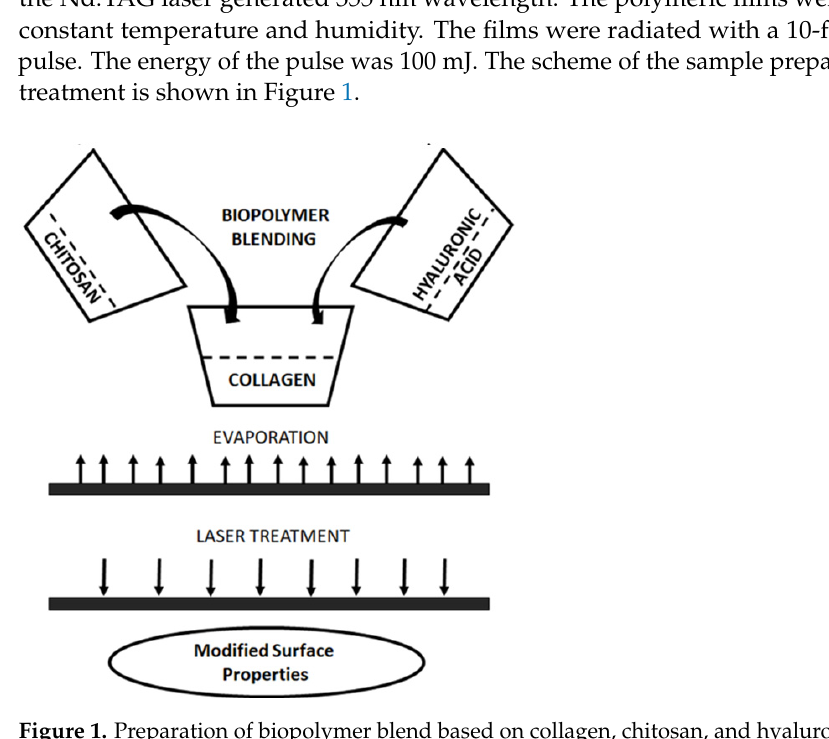
Figure 1. Preparation of biopolymer blend based on collagen, chitosan, and hyaluronic acid and laser treatment of biopolymer film.